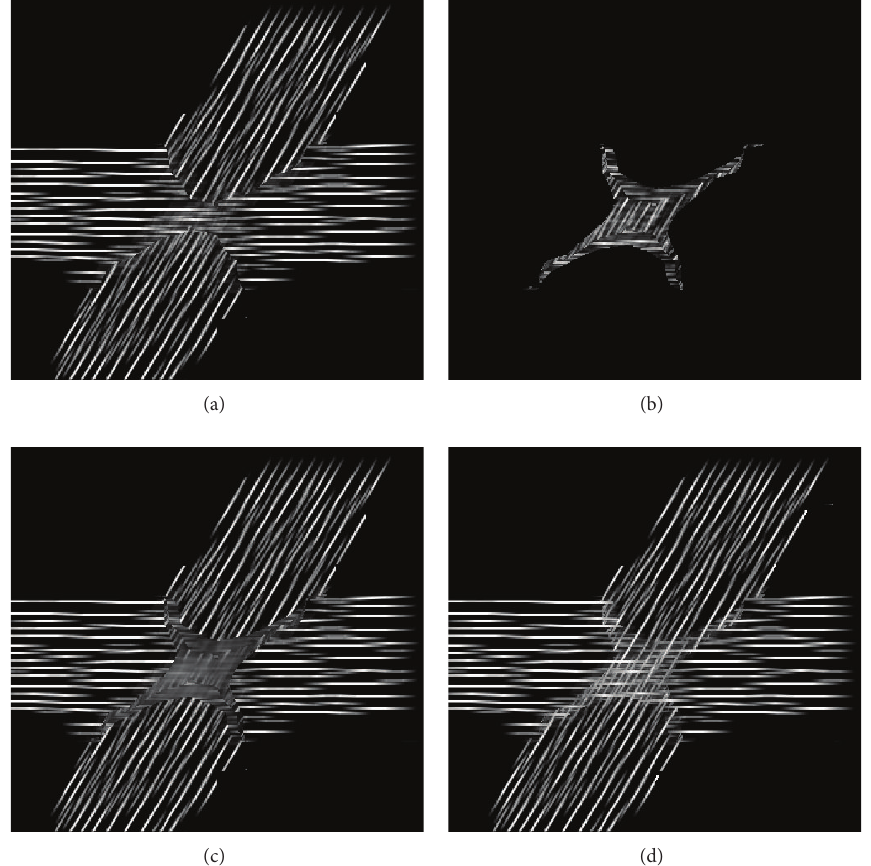
Figure 6: LIC results from HyperLIC and multiple-kernel LIC: first (a) and second (c) pass of HyperLIC, LIC result using the second direction only (b), and result from multiple-kernel LIC (d).